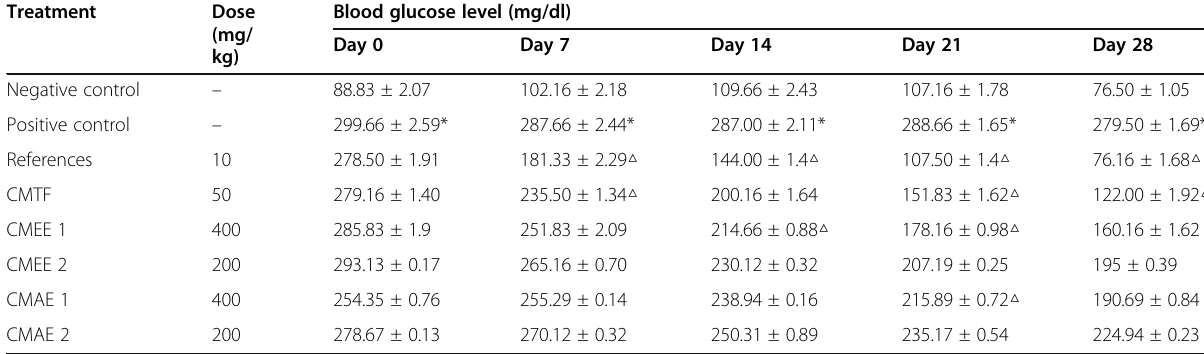
Table 3 Antidiabetic activity of C. melo fraction and extracts Treatment